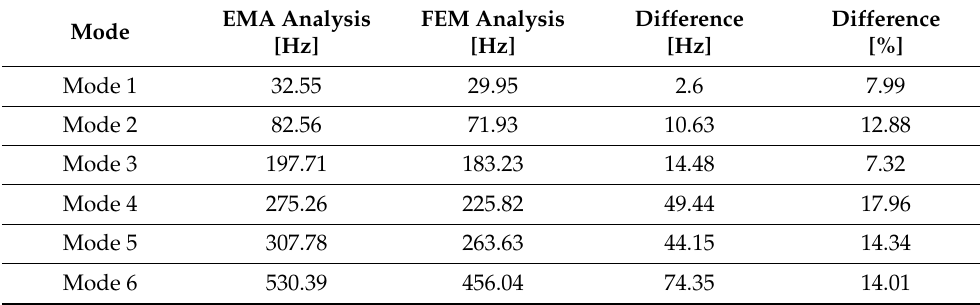
Table 1. Resulting eigenfrequency values obtained by EMA analysis and FEM analysis.